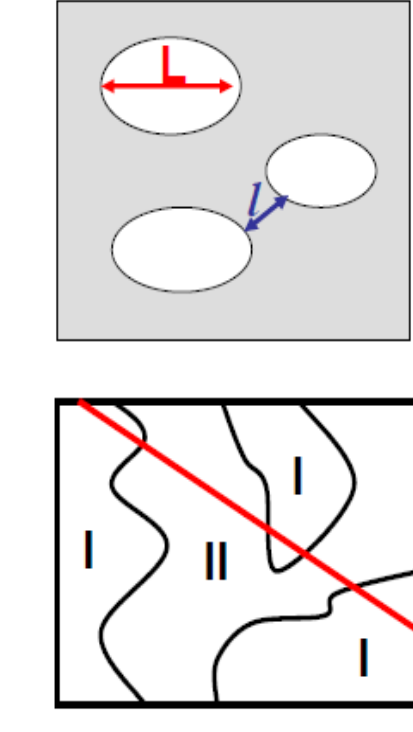
ClO 2 4 , l is 4 . In 4 orientations are indicated. Along the line 4